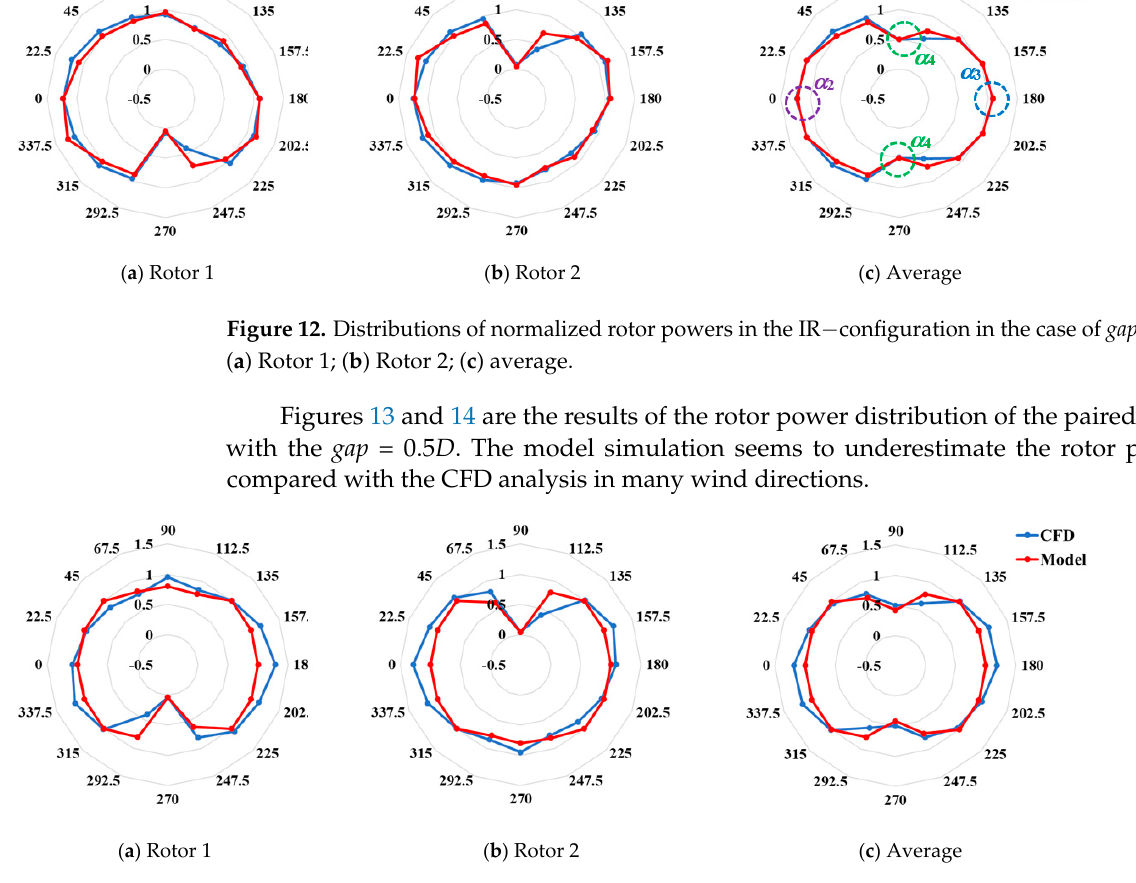
Figure 11. Distributions of normalized rotor powers in the CO-configuration in the case of gap = 1.0 D : ( a ) Rotor 1; ( b ) Rotor 2; ( c ) average.